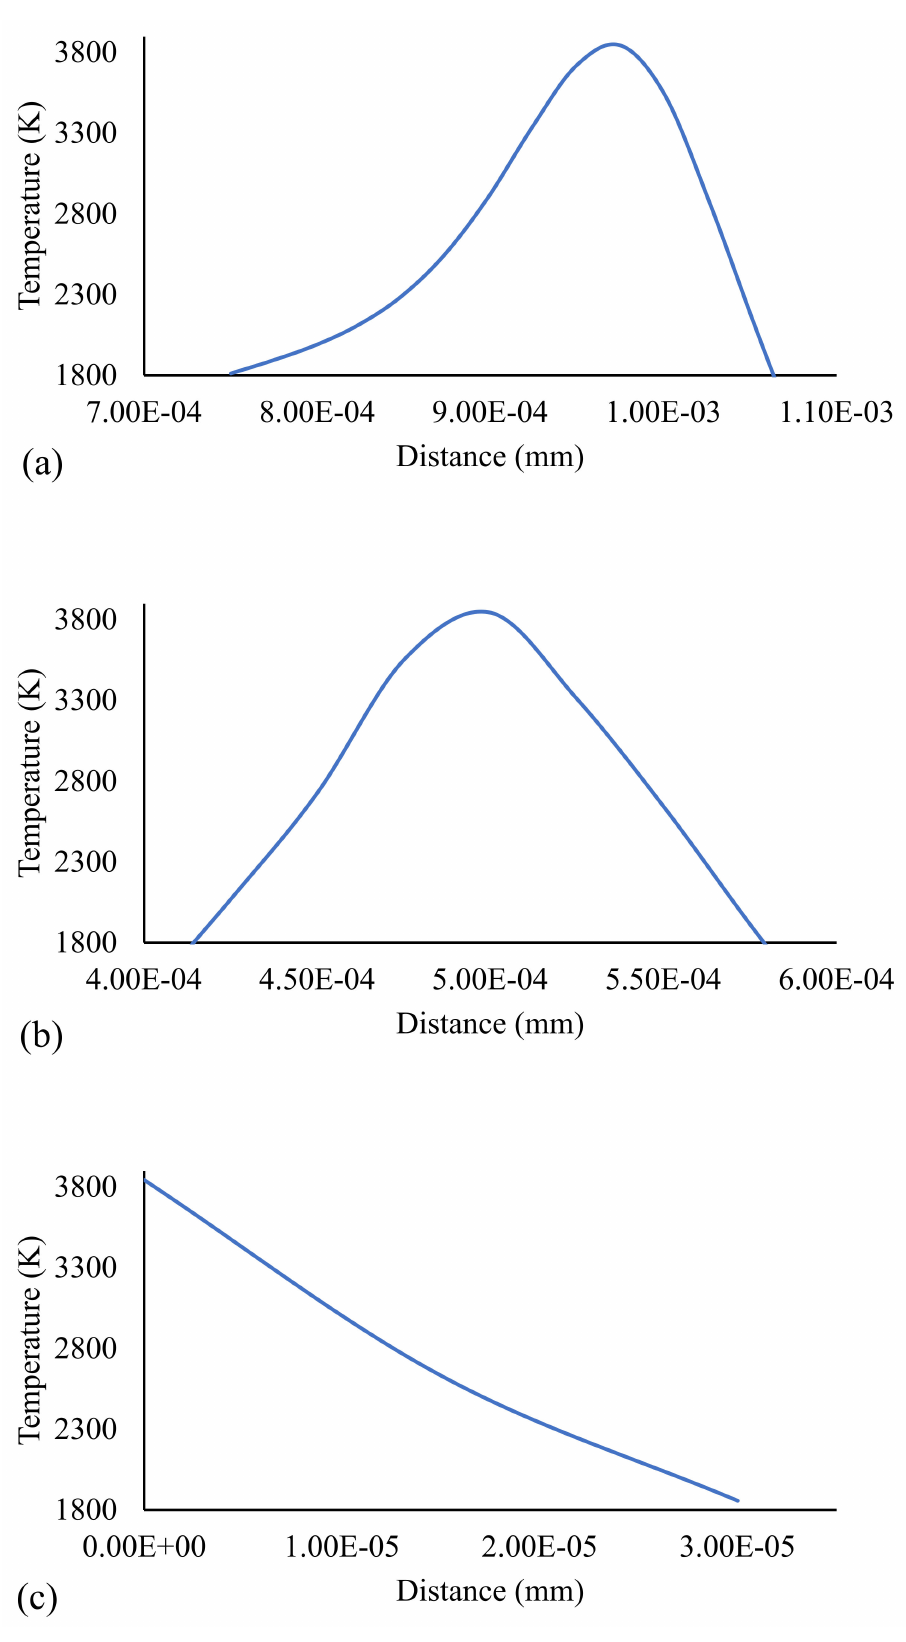
Figure 9. Variation of temperature along ( a ) length, ( b ) width, ( c ) depth of melt pool. For the case P = 80 W, v = 1 m/s, sp =